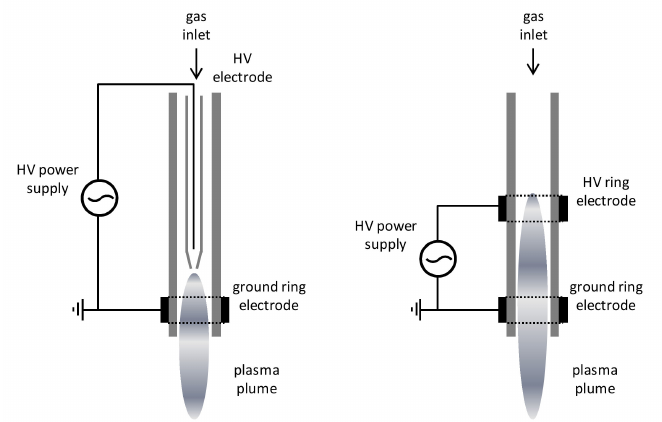
Figure 3. Design of two atmospheric pressure plasma jet (APPJ) sources. Glass (dielectric) tubes are in grey. Reprinted with permission from [19]. Copyright 2018